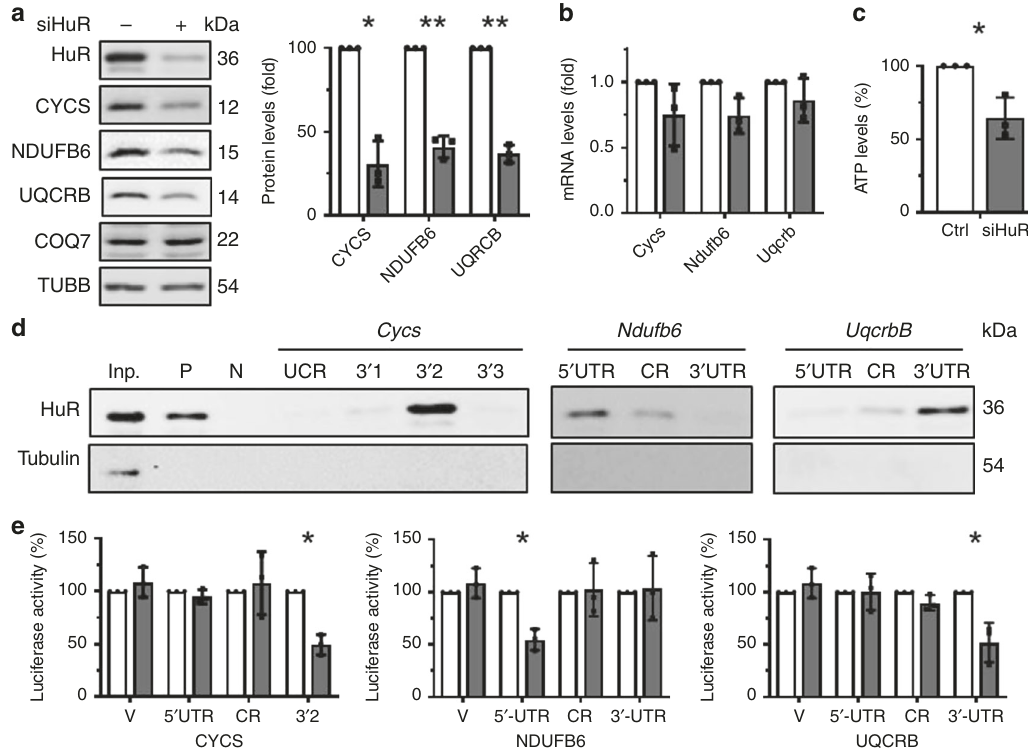
Fig. 7 HuR promotes ATP synthesis at least in part by regulating the levels of CYCS, NDUFB6, and UQCRB. a , b Mouse Hepa1 – 6 cells were transfected with HuR-directed or control siRNAs; 48h later, protein lysates and RNA prepared from cells were subjected to western blot analysis ( a ) and RT-qPCR analysis ( b ), respectively, to assess the levels of HuR, CYCS, NDUFB6, COQ7, UQCRB, and TUBB proteins ( a ) as well as the levels of Cycs , Ndufb6 , and Uqcrb mRNAs ( b ), respectively. Blank columns, control; Black columns, siHuR. c Cells described in a were subjected to ATP analysis. d RNA pull-down assays were performed by using Hepa1 – 6 cell lysates and in-vitro-transcribed RNAs depicted in Supplementary Fig. 16a. p27 5 ′ UTR and CR (coding region) served as positive (P) and negative (N) controls, respectively. A 5- µ g aliquot input (Inp.) and binding to TUBB were also assessed. Data are representative from three independent experiments. e Hepa1 – 6 cells were transfected individually with each of the reporters depicted in Supplementary Fig. 16d. Twenty four hour later, cells were further transfected with a HuR siRNA or a control siRNA and cultured for an additional 48h, whereupon the relative luciferase activities were determined. Blank columns, control; Black columns, siHuR. Data in panels ( a – c and e ) are the means± SD from three independent experiments; signi fi cance is analyzed by two-tailed Student ’ s t -test (** p < 0.01). All the error bars are equivalent throughout the fi gure. Source data are provided as a Source Data fi